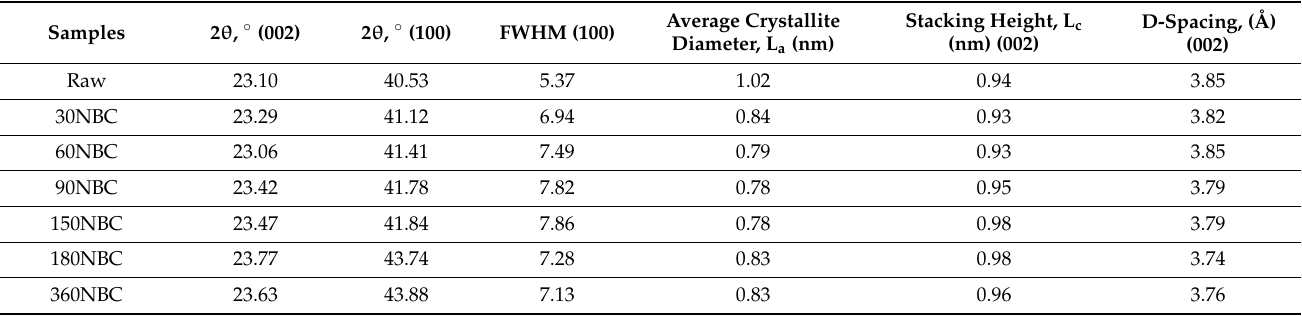
Table 3. The crystallite dimensions of BC and NBC at different ball milling dimensions.